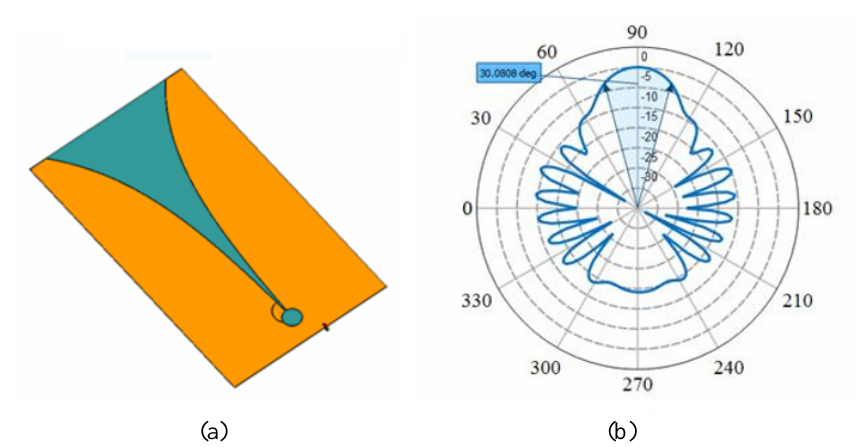
Fig. 7. Vivaldi antenna implementation (a) and its pattern at frequency of 3 GHz